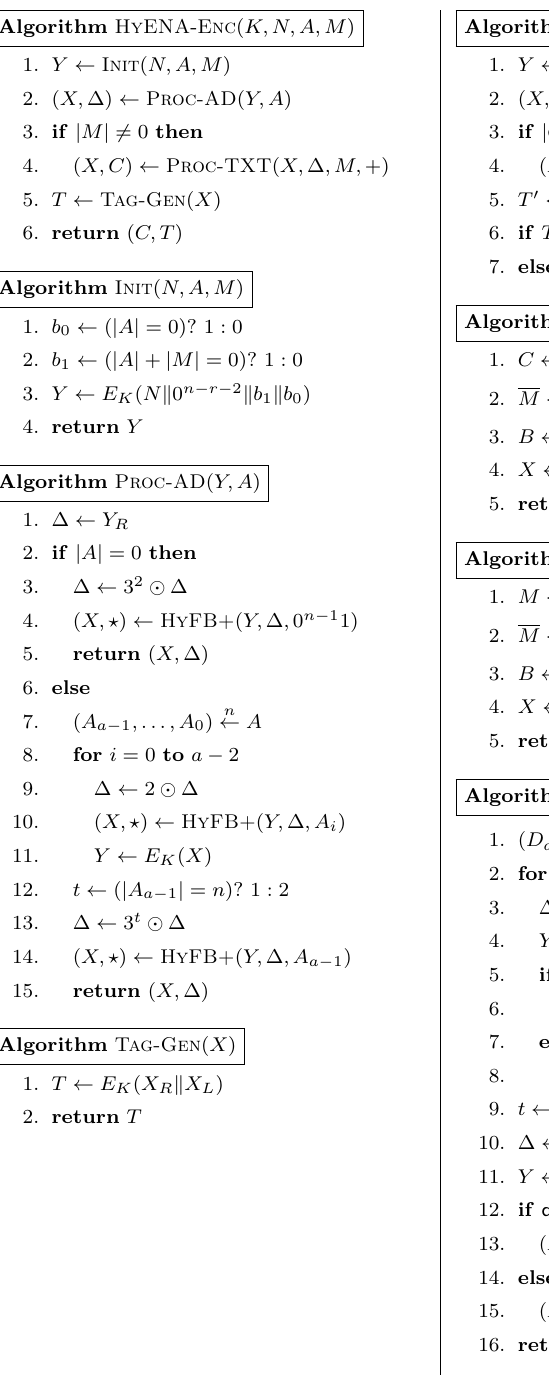
Figure 7: Formal Specification of HyENA Authenticated Encryption and Decryption algorithm. We use the notation ? to denote values that we do not